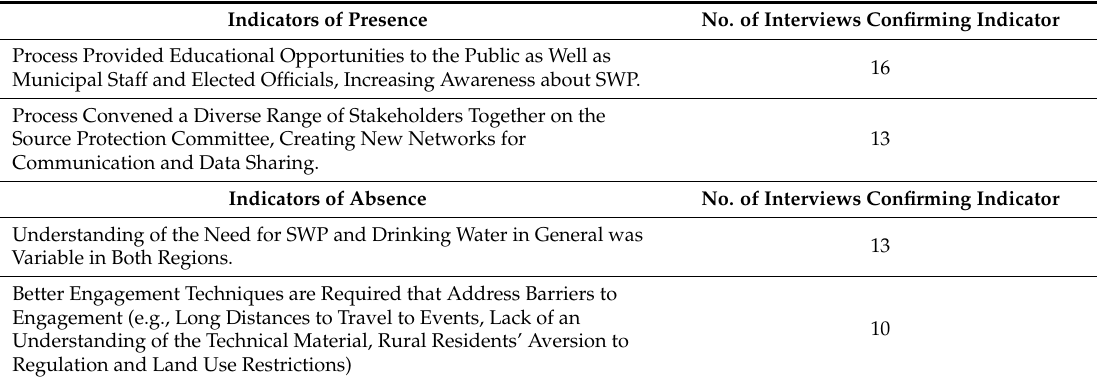
Table 6. Key Findings for Social